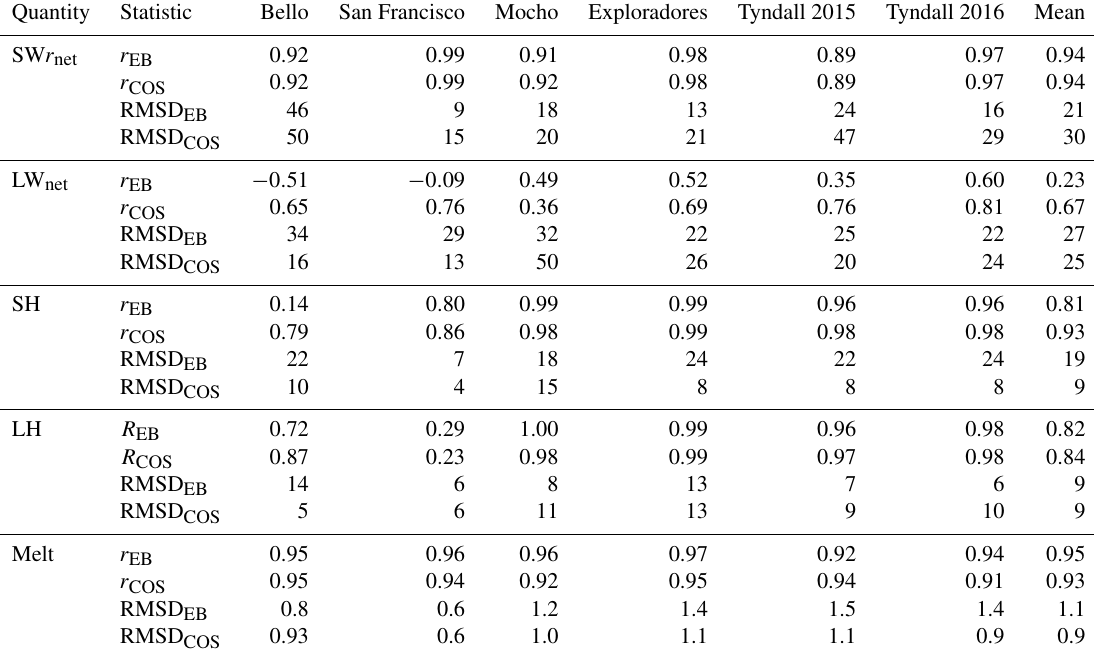
Table A1. Statistical comparison of the modeled daily energy fluxes and melt by the EB model and COSIMA with the Reference Database. Pearson correlation coefficient ( r ) and root-mean-square deviation (RMSD) are